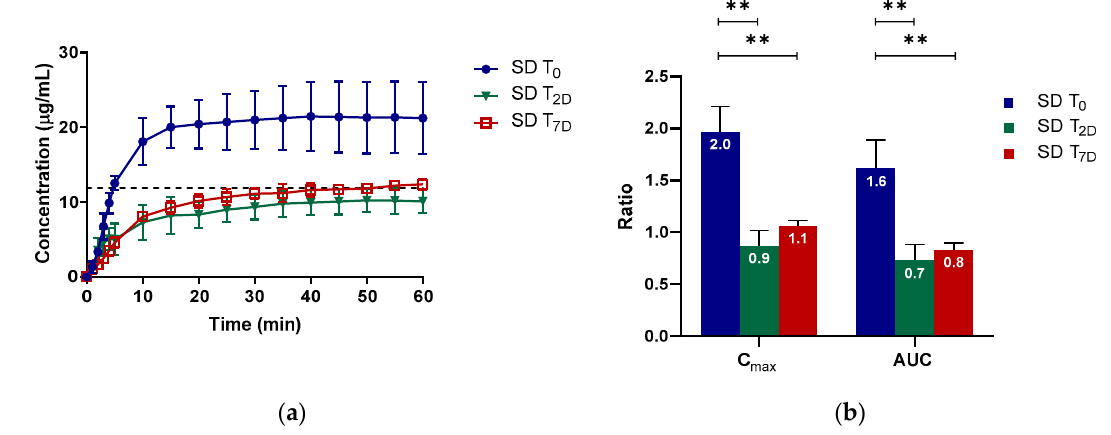
Figure 4. The ( a ) concentration–time profile and ( b ) C max,app and AUC ratios (R Cmax,app and R AUC ) of fresh (SD T 0 ), 2-day (SD T 2D ; 23% crystalline), and 7-day (SD T 7D ; completely crystalline) spray-dried ketoconazole stored at 75% RH. The mean ± standard deviation values of three replicates are shown. p < 0.01 is denoted **.